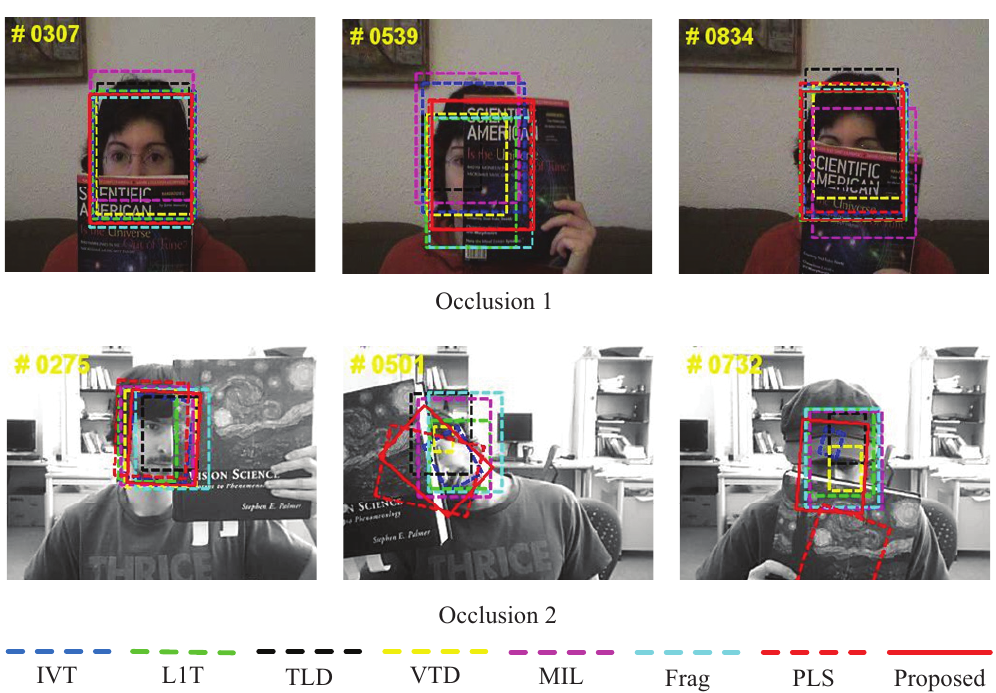
Figure 5. Qualitative evaluation results of eight algorithms on challenging tested sequences Occlusion 1 and Occlusion 2 .